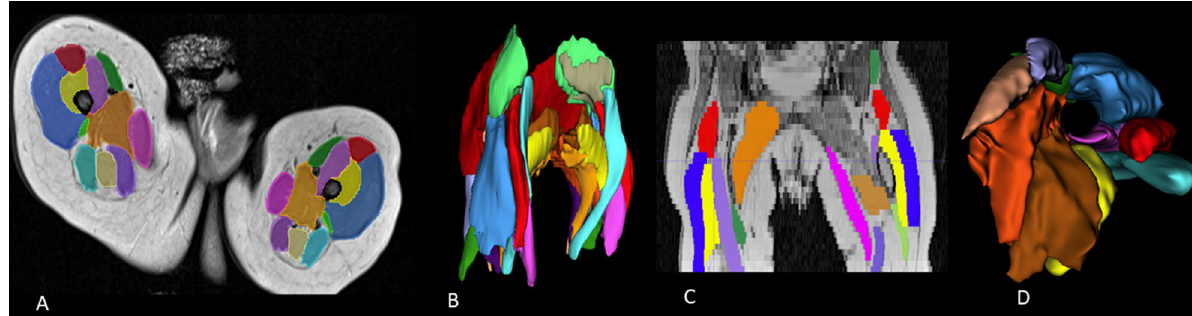
Figure 1. ( A ) Cross-sectional view of the muscles of an infant thigh, the outline of individual muscles are traced along its length to create a 3D model of the muscles. ( B ) 3D model from the anterior view. ( C ) Coronial view of the segmented muscles. ( D ) Superior view showing the path of the femur bone in the 3D trained under the guidance of a supervisor experienced in Slicer segmentation of paediatric muscles. Some key considerations in the Slicer protocol included; (i) grouping together adductor magnus, adductor longus, and adductor brevis as one muscle mass due to the difficulty distinguishing muscle borders, a technique common with other studies 28 ; (ii) excluding tendon attachments of muscles and only considering the muscle belly; (iii) considering the border of a muscle to be the outermost part of the muscle where the colour and contrast was distinctly different to that of the surround tissue. The 3D Slicer programme allows for visualisation and manual segmentation in axial, sagittal, and coronal views. After first marking muscle boundaries in the axial view, raters were then able to translate the MRI into sagittal and coronal planes to allow for correct muscle border selec- tion and maximum voxel inclusion. Once muscle segmentation was completed, the ‘Segment Statistics’ module inbuilt into the 3D Slicer programme was utilised to calculate muscle volumes for each muscle that was manually segmented. DICOM files define the precise location and thickness of a MRI slice, allowing for the reconstruction of the muscles into a 3D model (Fig. 1). A combined total of over 800 h of manual segmentation was undertaken by both raters to complete the segmentation. Muscles of the Knee Extensor muscle group (rectus femoris, vastus lateralis, vastus medialis), and the Knee Flexors muscle group (biceps femoris brevis, biceps femoris longus, semitendinosus, semimembranosus, and gracilis) were segmented for analysis. For intra-rater reliability analysis, a total of 10 limbs were segmented from 10 MRI scans (n = 9 participants for the knee extensor muscles (GW), n = 10 participants for the knee flexor muscles (JL), with segmentation repeated 2 months later. The discrepancy between the number of infants included in the extensor muscle and flexor muscle analysis was a result of independent reviewers’ scan selection. For assessment of inter-rater reliability, two raters independently segmented the muscles of interest from ten scans (n = 9 participants, one participant completing two scans 3 months apart), with limbs from five participants segmented bilaterally, and scans from five participants segmented unilaterally. Statistical analysis. All statistics were calculated with SPSS (IBM SPSS Statistics Version 26 for MacOS). The test–retest reliability of intra-rater and inter-rater measurements was analysed using intraclass correlation coefficients (ICC), with an ICC measuring below 0.5 rated as poor, between 0.5 and 0.75 moderate, 0.75–0.9 good, and greater than 0.9 rated as excellent reliability 28 . Box and whisker plots were used to provide a graphi- cal representation of the inter-rater percentage variation in measures for different muscles, calculated as the difference in interrater measurement divided by the mean of the two measurements, with a Kruskal Wallis non- parametric ANOVA used to look for differences between group median percentages. Bland Altman analyses were used to further define the degree of bias in measures and calculate the 95% limits of agreement (LoA). Absolute reliability was defined using standard errors of measurement (SEM)’s which were calculated according to the equation